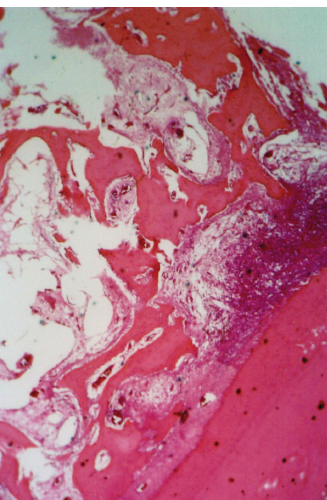
Figure 2: Severe inflammatory infiltration around perforation treated with carrier alone after 3 weeks (magnification × 100).